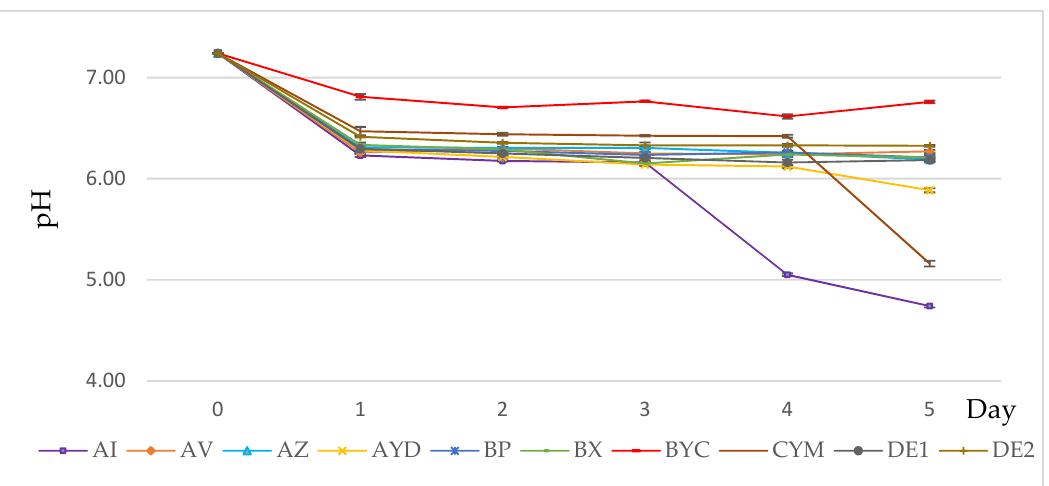
Figure 4. Evolution of the pH of the medium of the selected Actinomycete strains grown in AMM + orthoclase. Error bars represent standard deviations of the mean values of the results of three independent culture replicates.